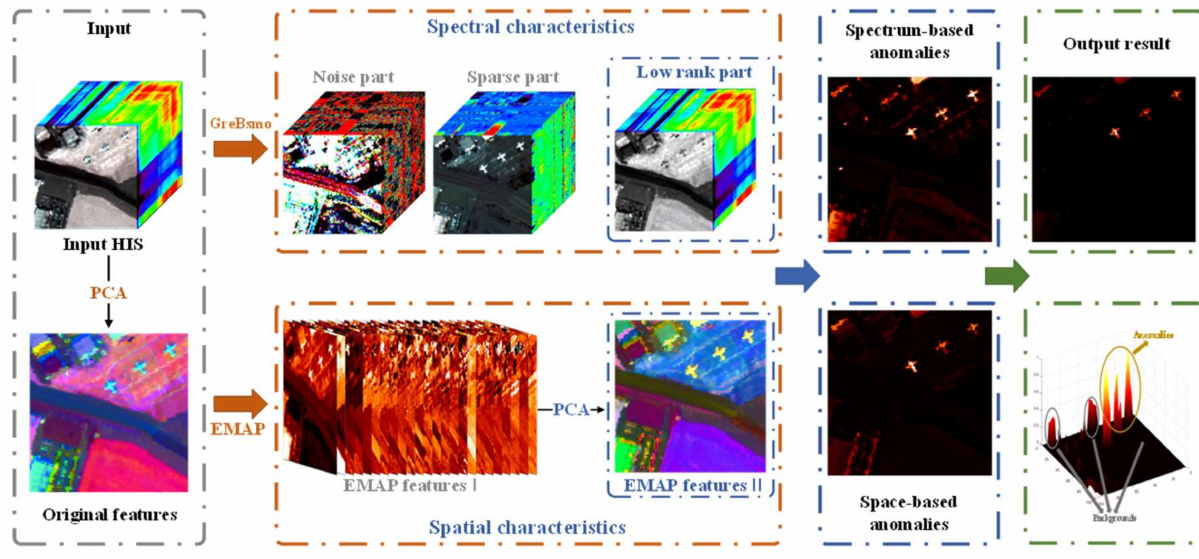
Figure 1. Flowchart of the GBSAED